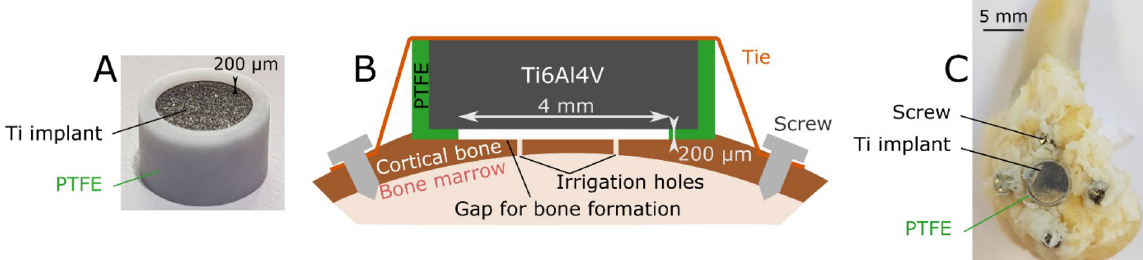
Figure 1. ( A ) Dedicated experimental model, designed as a coin-shaped implant, presented upside down— the bone chamber is visible (example of an implant from the R series). ( B) Schematic cross-sectional view of the model once implanted, with the 200 µm-thick bone chamber below the implant. ( C ) Medial view of an implanted distal femur, after medial femur and one at the proximal-medial tibia. Each left (respectively right) side received two implants from the S (respectively R) series. After a subcutaneous injection of 0.03 mg/kg buprenorphine (Bupaq, Virbac, Carros, France) 30 min before surgery, the animals were anesthetized via intramuscular injection of 0.5 mg/kg diazepam (Valium, Roche, Basel, Switzerland), 0.25 mg/kg metedomidine hydrochloride (Domitor; Virbac, Carros, France) and 20 mg/kg ketamine hydrochloride (Ketamine1000, Virbac, Carros, France). They were intubated with a 3 mm endotracheal